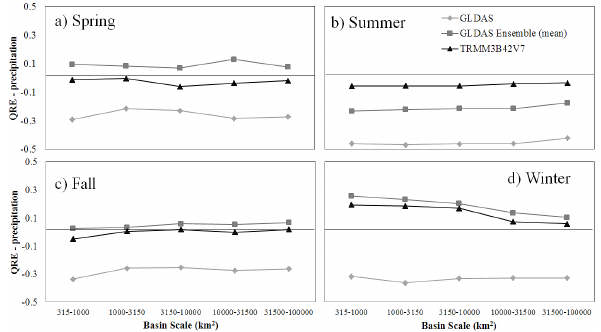
Figure 9. QRMSE error metric determined conditional to reference precipitation values exceeding their 90th percentile. The horizontal axis indicates basin-scale categories presented in Table 2. Results are presented for spring (upper left panel), summer (upper right), fall (lower left), and winter (lower right)